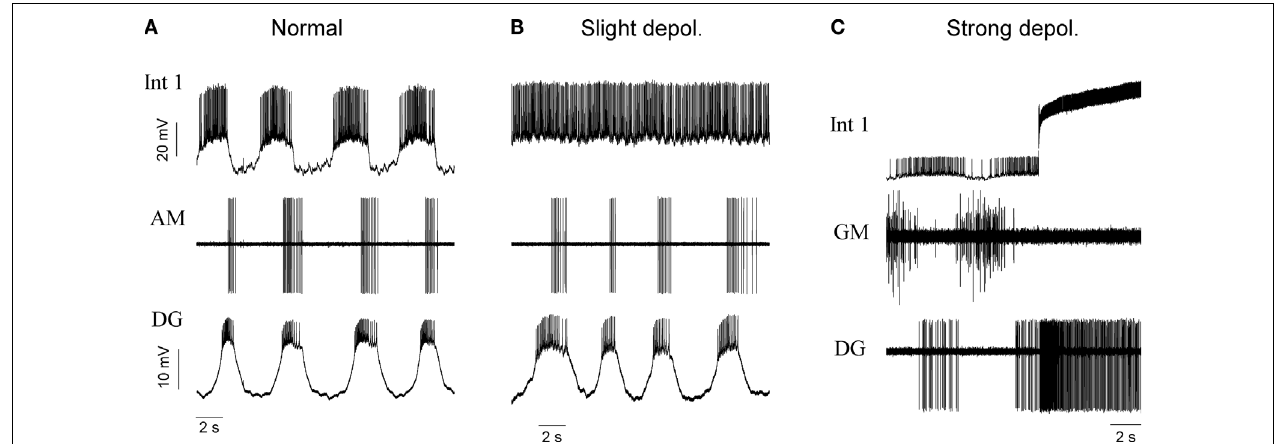
FIGURE 4 | The effects of Int 1 depolarization on the activity of the medial tooth subcircuit. The normal rhythm of the subcircuit is shown in the (A) panel. A small depolarization of Int 1 to a steady fi ring level permits DG and AM to